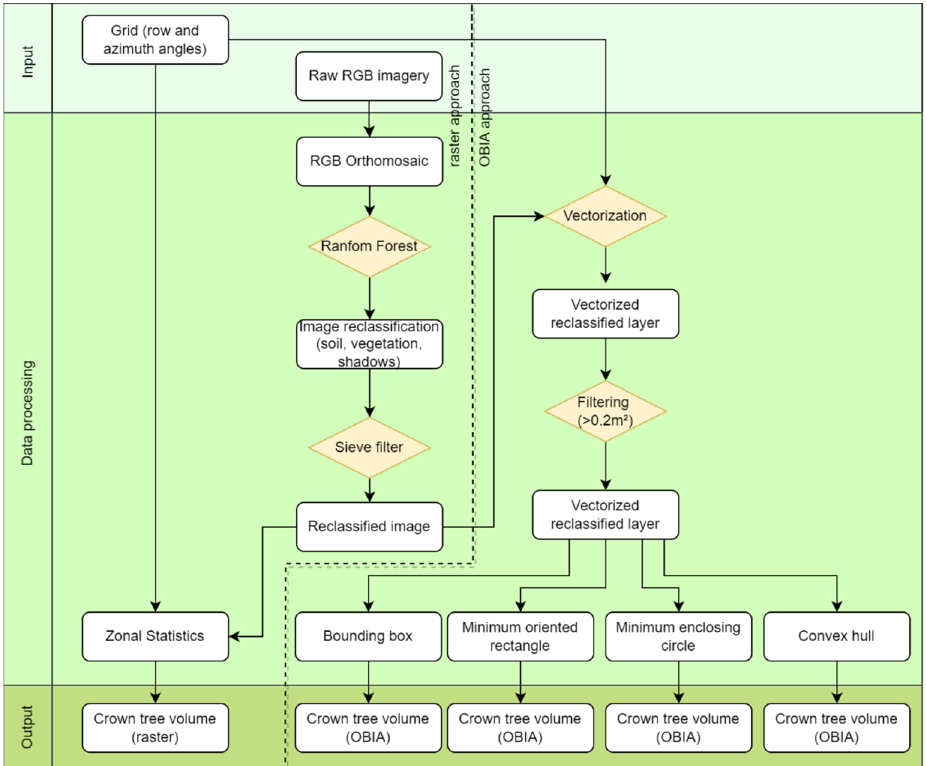
Figure 3. Workflow. Both methodologies employ a grid based on the planting pattern and the solar azimuth to identify each tree, assigning a plant id from the polygon id. The orthomosaic is generated using RGB images, and segmented using random forest algorithm into three classes: vegetation, soil and shadows. The product is analyzed in two ways: (a) using a raster approach (pixel-based classification), analyzing the number of pixels of each class within each polygon and (b) an OBIA (Object-Based Image Analysis) approach, enveloping the pixels within several geometries.